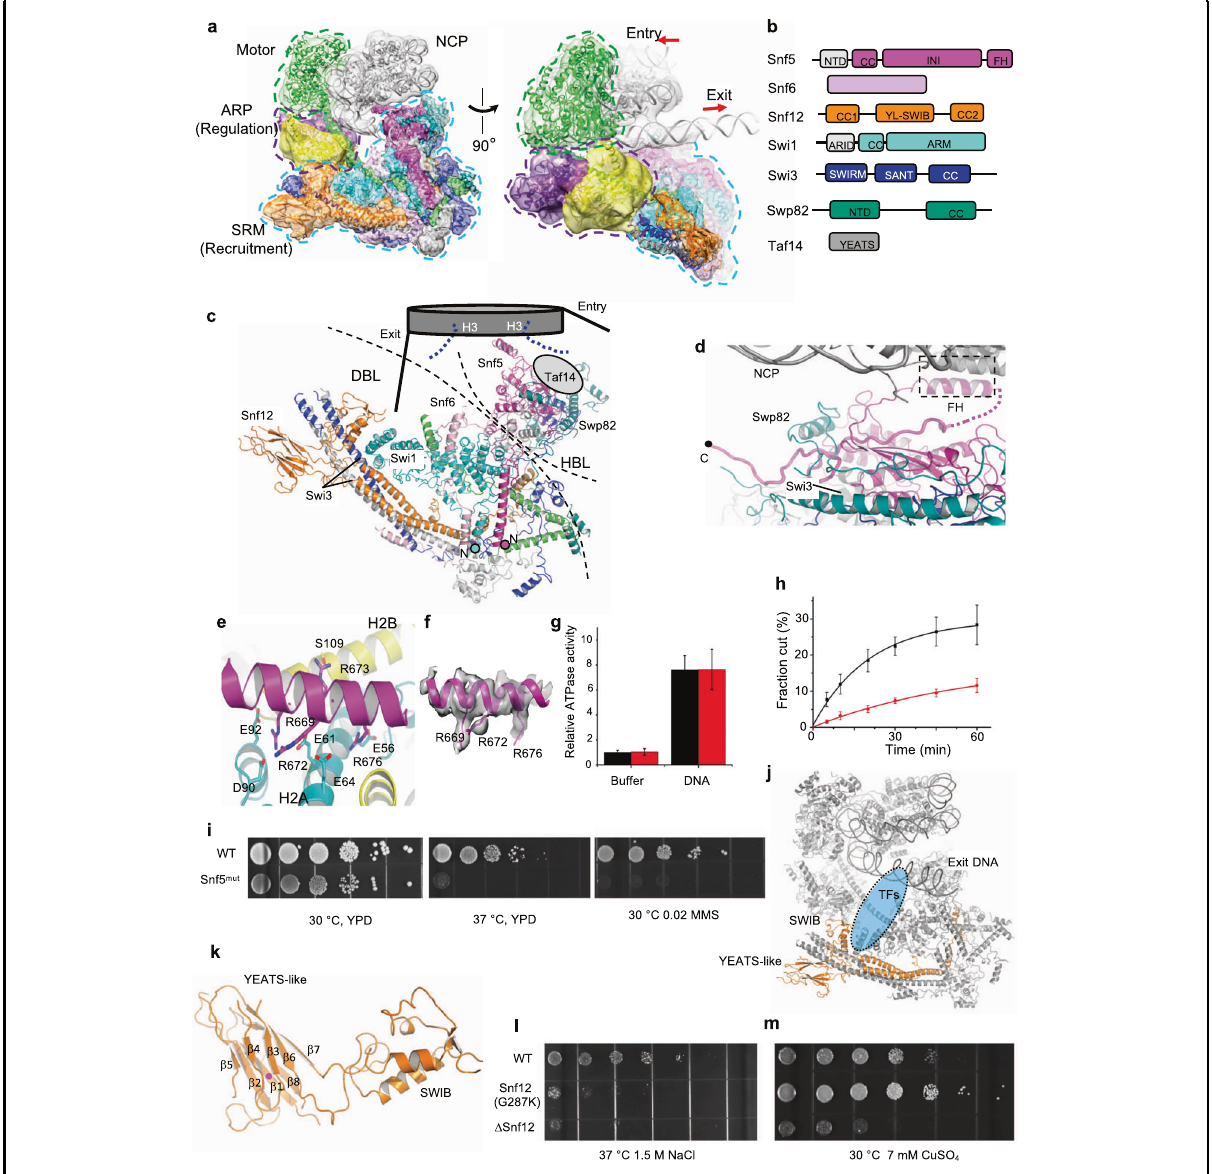
Fig. 1 Structure of the SWI/SNF – NCP complex. a Two different views of the cryo-EM density superimposed with the structure of the SWI/SNF – NCP complex, showing the overall modularity (motor-regulation-recruitment) of the complex. Arrows indicate the directions of DNA translocation suggested by the binding position of the motor (Snf2). b Domain organization of the subunits within the SRM. YL-SWIB, the topologically linked YEATS-like and SWIB domain. c Structure of the SRM of the SWI/SNF complex. The proposed position of Taf14 subunit is indicated by the gray oval. The N-termini of Snf5 and Swi1 are labeled. d Structure of the C-terminal tail of Snf5. The boxed region is further analyzed in e . e Binding of the FH of Snf5 to the acidic pocket of H2A – H2B. f Local EM density map of the FH. g Relative ATPase activities of WT (black) and Snf5 mutant (red). Error bars indicate SD of the mean ( n = 3 independent experiments). h Nucleosome remodeling activities of WT (black) and Snf5 mutant (red). Error bars indicate SD of the mean ( n = 3 independent experiments). i Growth assays of yeast cells with WT and Snf5 mutant. All assays were performed in triplicate, and the representative ones are shown. j Structure of Snf12 (orange) within the NCP-bound SWI/SNF complex (gray). k Structures of the YEATS-like and SWIB domains. Arg126 is marked as a magenta dot. l The Snf12 mutation (G287K) resulted in sodium chloride sensitivity. m The Snf12 mutation (G287K) conferred copper sulfate